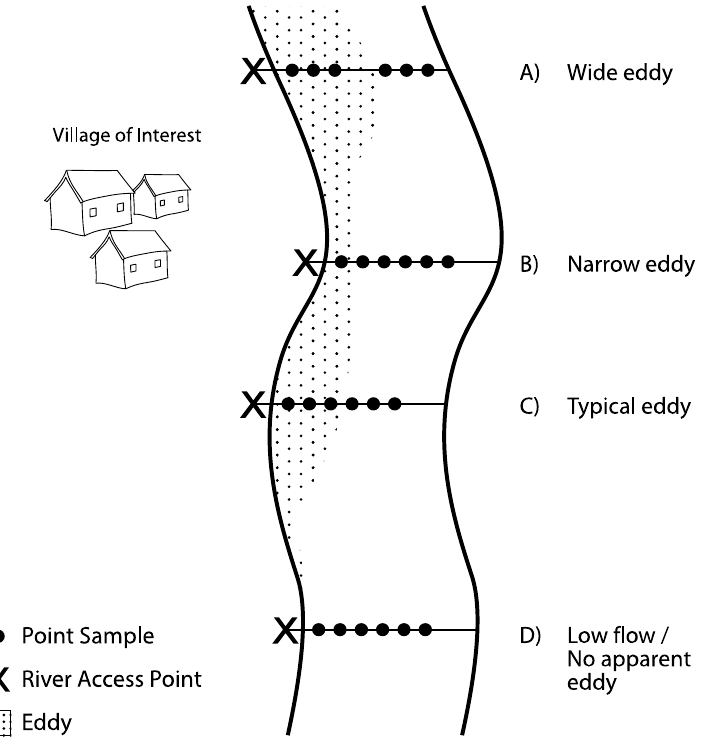
Figure 1. Field sampling schematic. At each village of interest, we sampled at sites along the banks of the river where the population accesses the river. We established river transects perpendicular to the river bank and took samples 2 m apart either within or outside of the eddy. Four different situations occurred, depending on the geometry of the river: ( A ) Wide eddy: when the eddy was >6 m wide, we took three samples within the eddy (each collected 2 m apart) and three samples outside of the eddy (each collected 2 m apart), with a gap between the third and fourth sample; ( B ) Narrow eddy: If the eddy